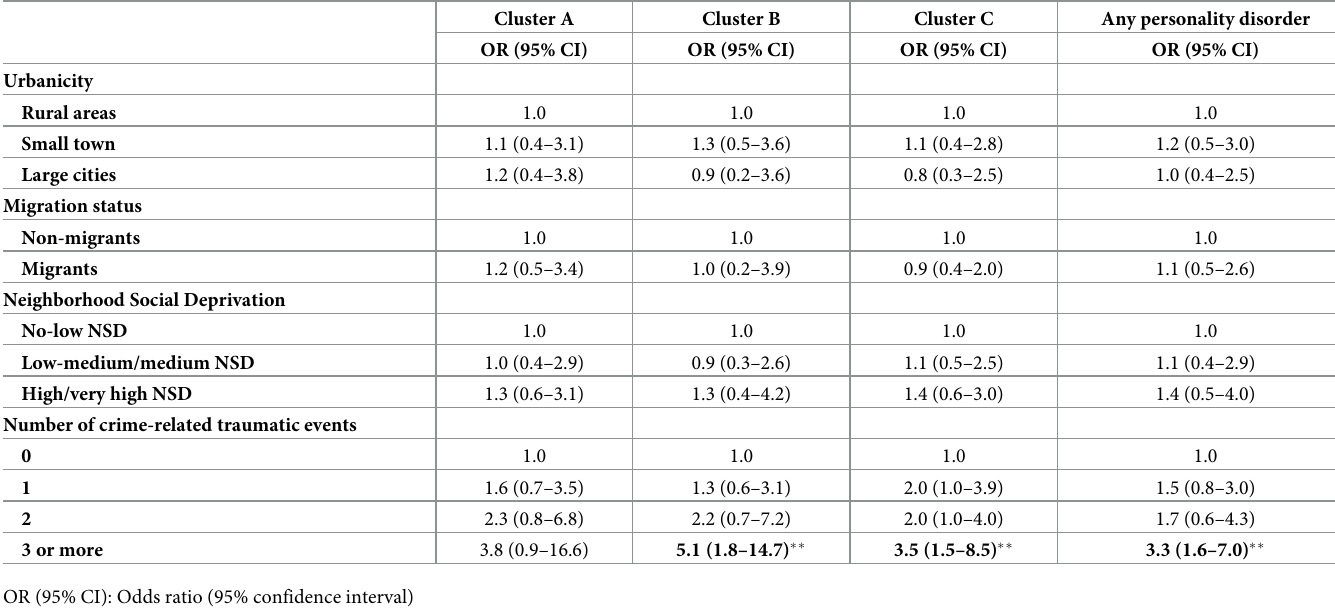
Table 3. Association of personality disorders with urban stressors in the Sao Paulo Metropolitan Area, adjusted for sex, age and all urban stressors